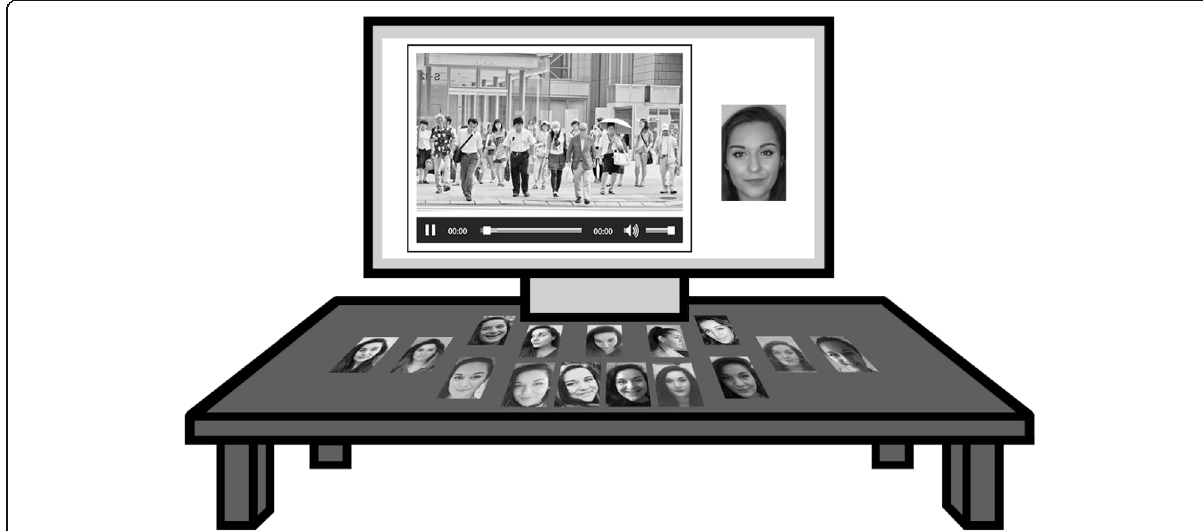
Fig. 3 Representation of a face-search trial. The search target on the screen is from a custody image. Image cards placed on the desk were available on half the trials. They show an example of the type of photos available for a particular target. Legal restrictions prevent publication of the originals. The target person shown here is a volunteer who has given permission for the images to be reproduced. See the attributions for the closed-circuit television (CCTV) image in “ Acknowledgements ”